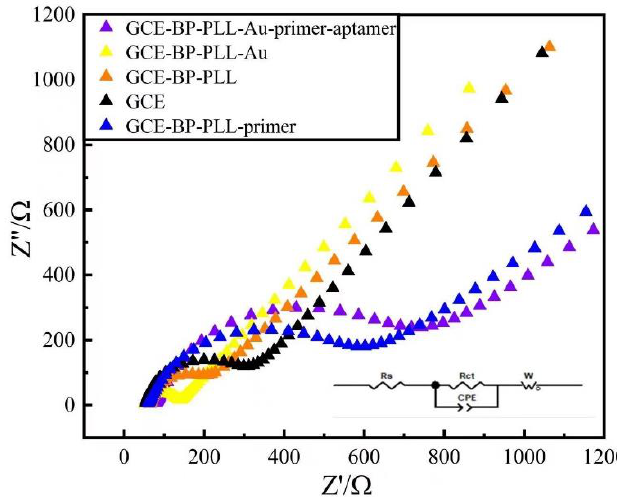
Figure 4. Nyquist plots for the electrodes in 10 mM K 3 Fe (CN) 6 solution at open − circuit potential conditions (AC frequency range: 0.1 Hz to 10 5 Hz; AC amplitude: 5.0